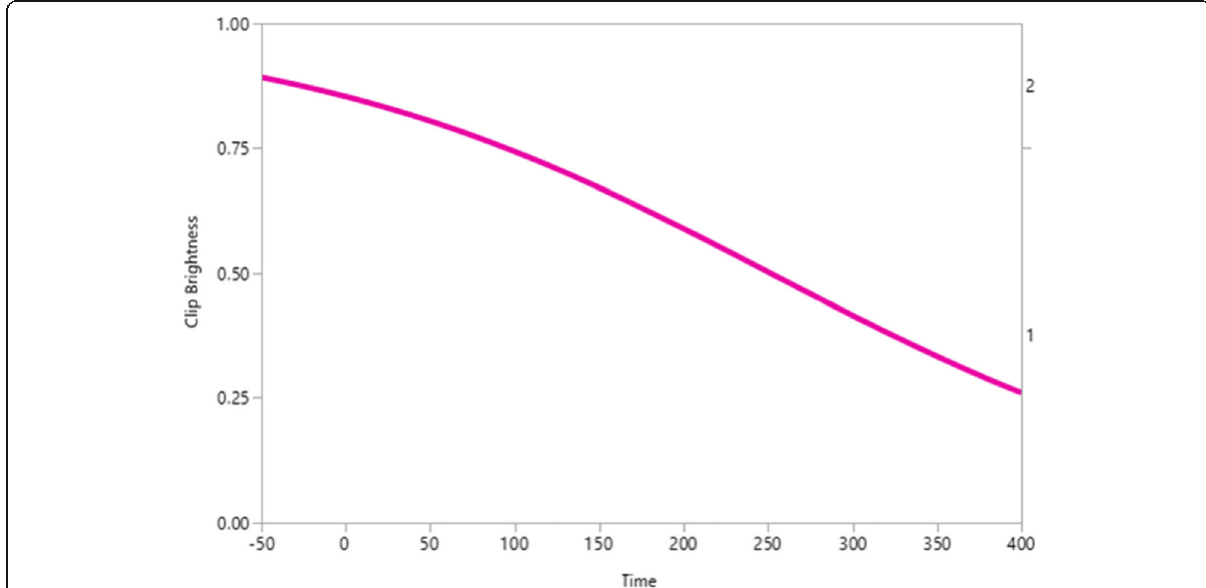
Fig. 4 Plot for marker brightness versus time (days). Data are referred to HydroMARK marker on T2-weighted water-only fast spin-echo